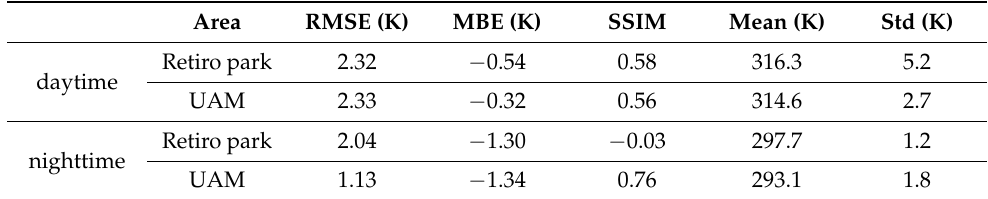
Table 10. RMSE, MBE and SSIM between the 60-m LST from the 1MMD-4-band TES and the aggregated 4-m to 60-m LST from the 1MMD-4-band TES and 1st-order statistics of the former.